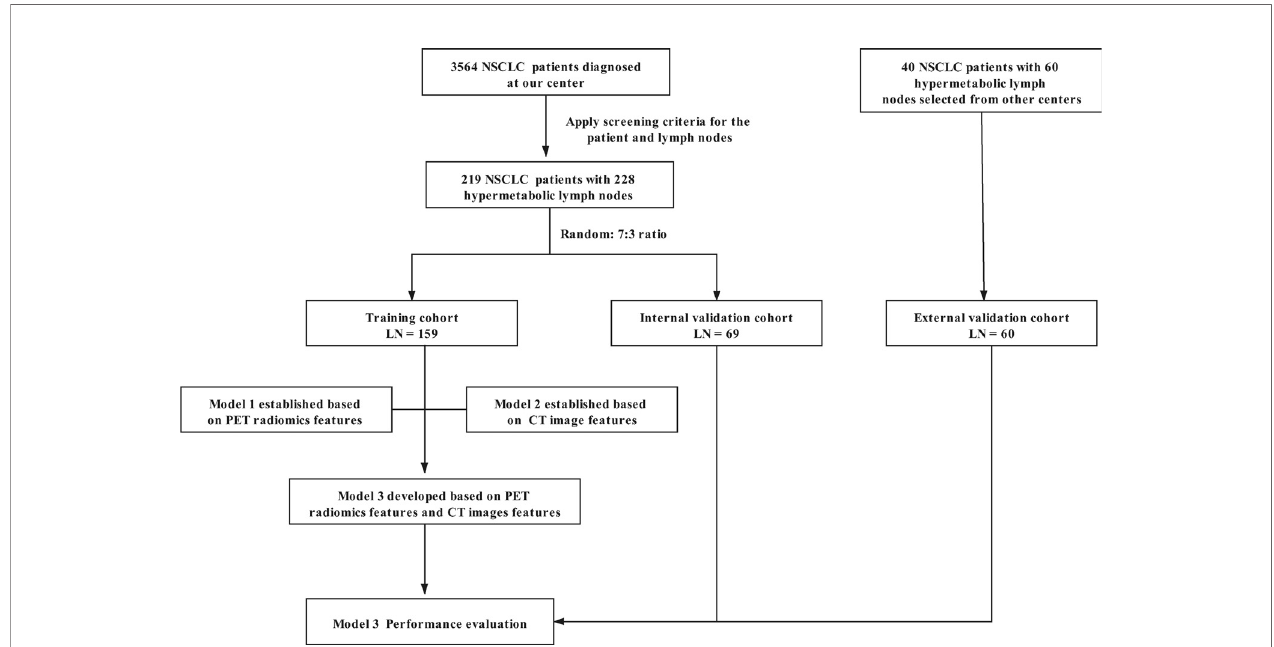
FIGURE 1 | The fl owchart shows the process of LN enrollment and